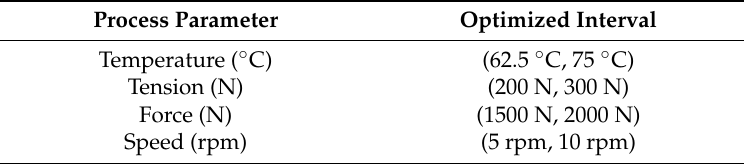
Table 8. Comprehensive optimized interval of winding parameters.